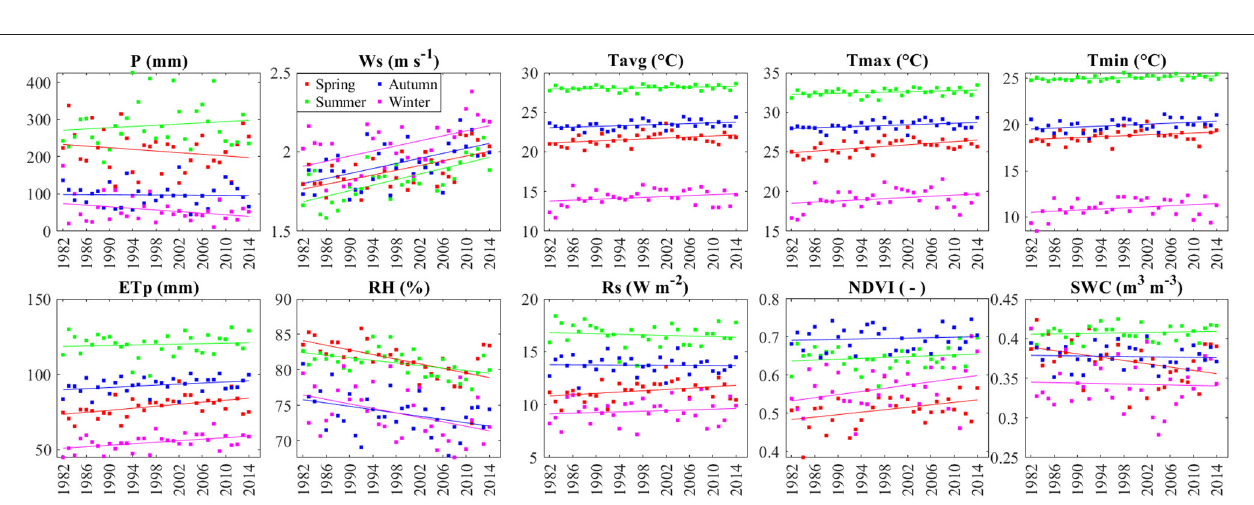
FIGURE 4 | Seasonal trends of the investigated variables over the province during 1982–2015. Lines are linear regressions for different seasons. Data and linear trends are indicated by different colors as given in the legend in the second plot of the upper panel. Statistics are given in Table 2 for these linear regression